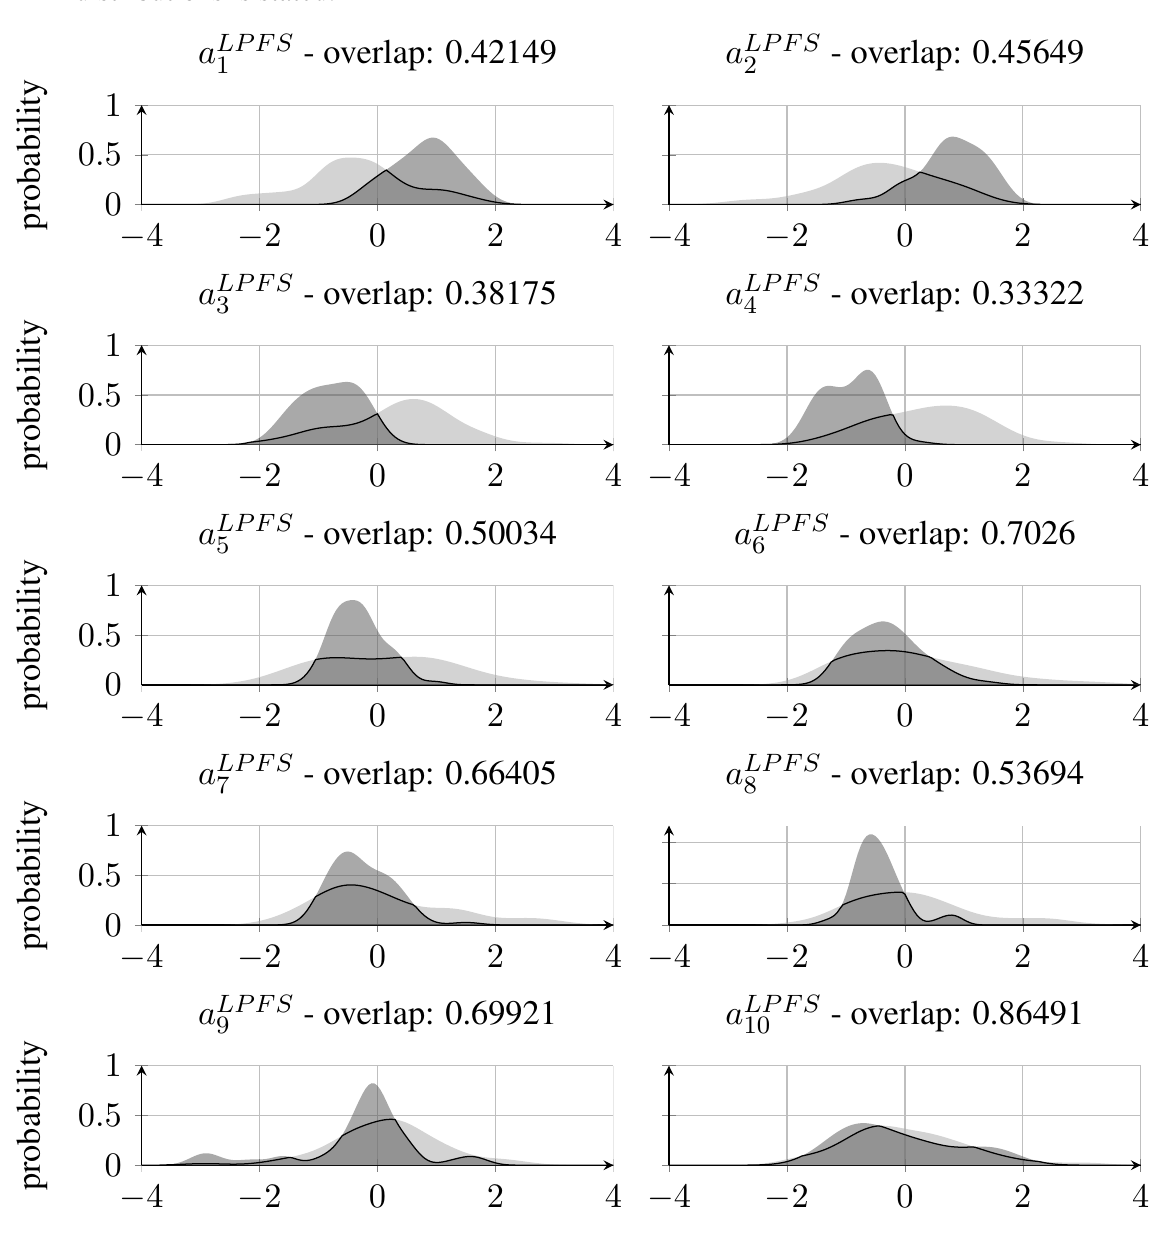
Figure 8. Distribution of the LPFS feature set generated from D (light grey) and cornflower (dark grey). For each subfigure the amount of overlap between distributions is